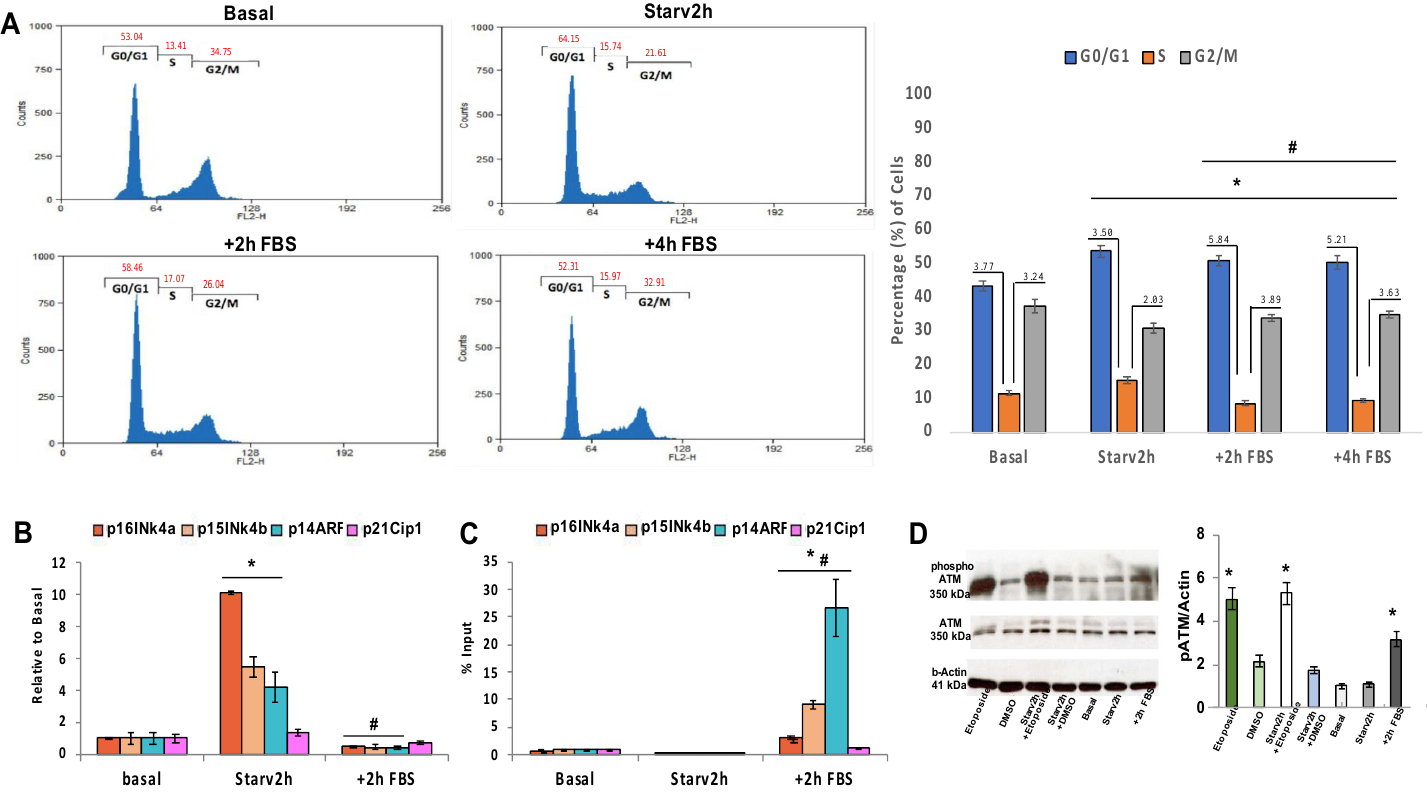
Figure 2. Serum addition to transiently starved cells induced DNA synthesis, transcription and DNA damage in CDKN2A / B genes. ( A ) Total RNA was extracted and analyzed by qRT-PCR with primers corresponding to p16INK4a ( CDKN2A ), p15INK4b ( CDKN2B ), p14ARF ( CDKN2A-ARF) , and p21Cip1 ( CDKN1A ) (Table 1). ( B ) Cell cycle was analyzed with the FACSCAN (BD, Heidelberg, Germany) and the software WINMDI. ( C ) Chromatin immunoprecipitation with phospho- γ H2AX antibody was performed as described in the Materials and Methods. The input DNA values were used to normalize the ChIP samples. ( D ) Immunoblot analysis of phospho S1981 ATM and total ATM protein levels in HeLa cell extracts, derived from cells treated with DMSO, or starved or exposed to serum as indicated in the Materials and Methods and in the text. β -Actin was used as loading control. The statistical analysis was performed on three independent experiments in triplicate (n = 9; mean ± SD); * p < 0.05 (matched pairs t -test) compared to Basal; # p < 0.05 (matched pairs t -test) compared to Starv 2